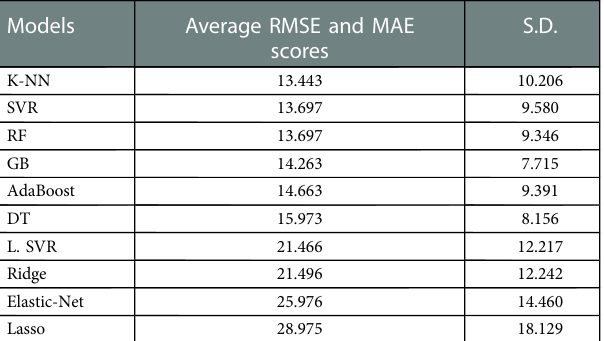
Table 4 The average RMSE and MAE values for the validation data.